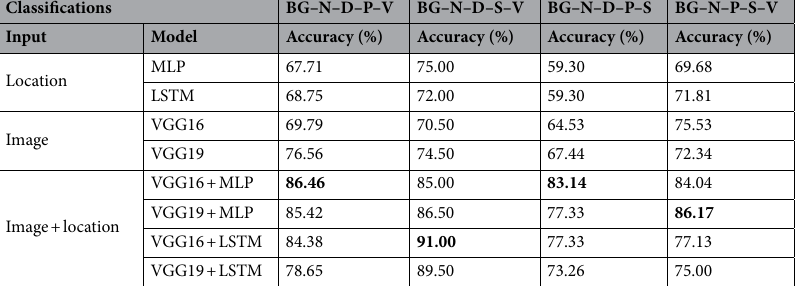
Table 6. Four five-class classifications on AZH dataset. The bold represents the highest results/accuracy achieved for each experiment.